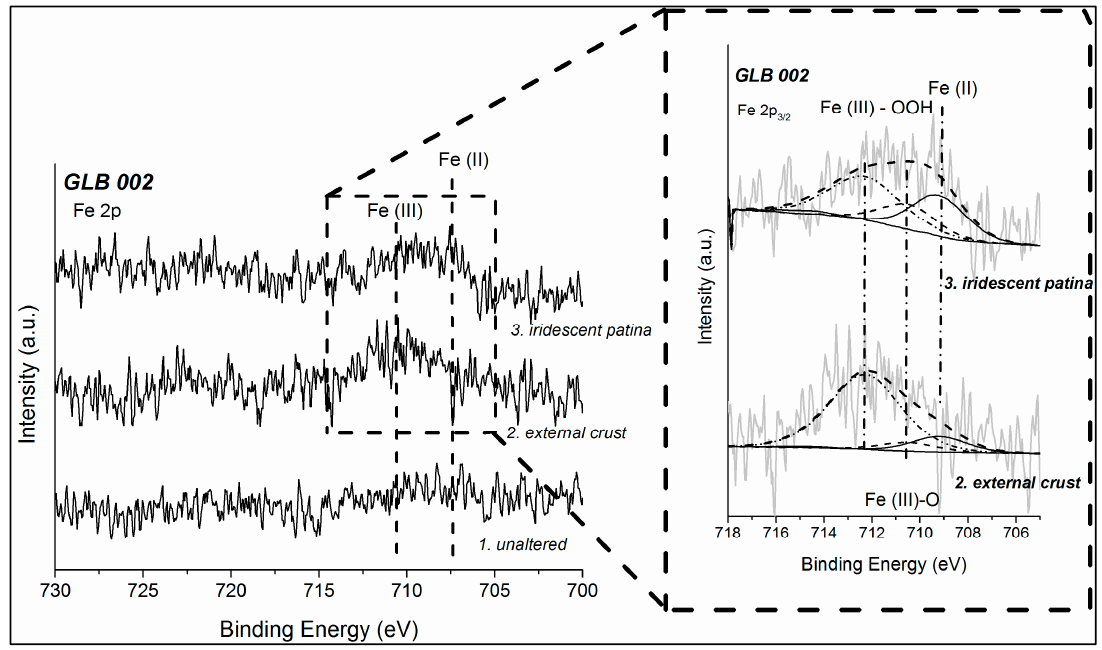
Figure 7. Fe 2p peak obtained on the sample GLB002 in point 1, in the external crust (point 2) and in the iridescent patina (point 3). the iridescent patina (point